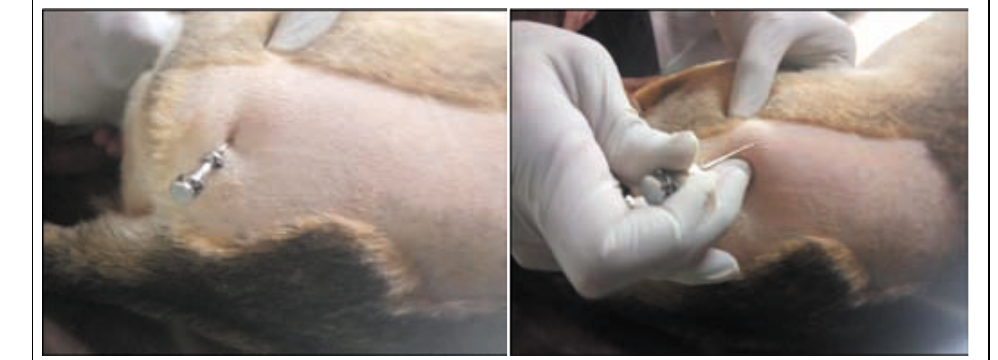
V Fig. 1. Bone marrow aspiration with needle inserted through the inter-trochanteric fossa of left femur J .